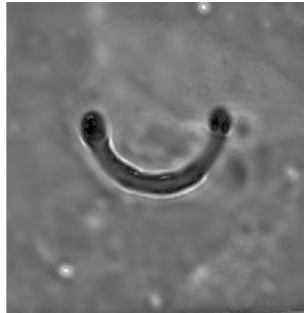
Fig. 4. SAM image taken from the surface